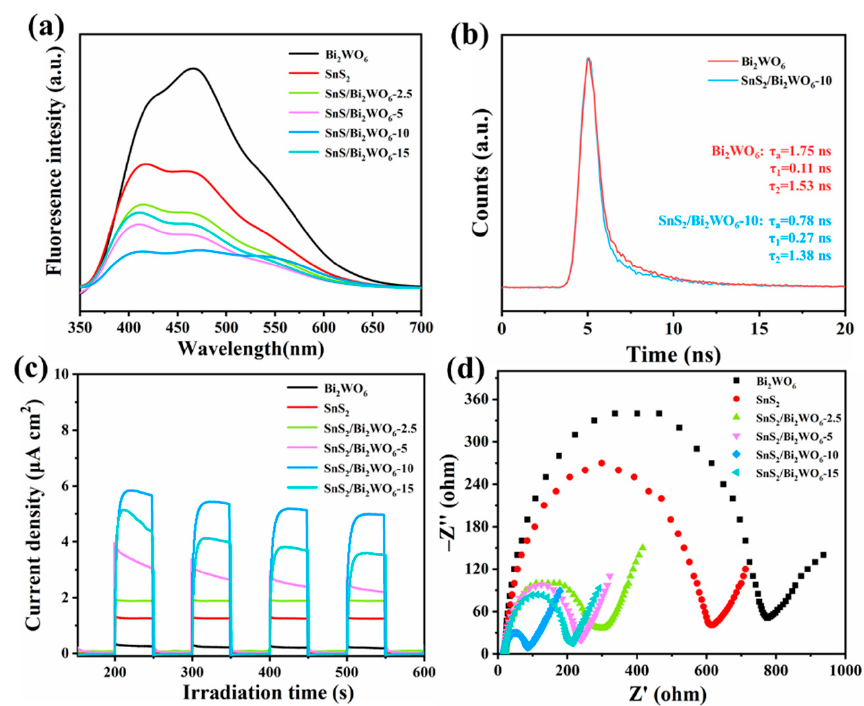
Figure 5. ( a ) Photoluminescence spectra, ( b ) time-resolved PL decay spectra, ( c ) transient photocur- rent response, ( d ) EIS Nyquist plots.